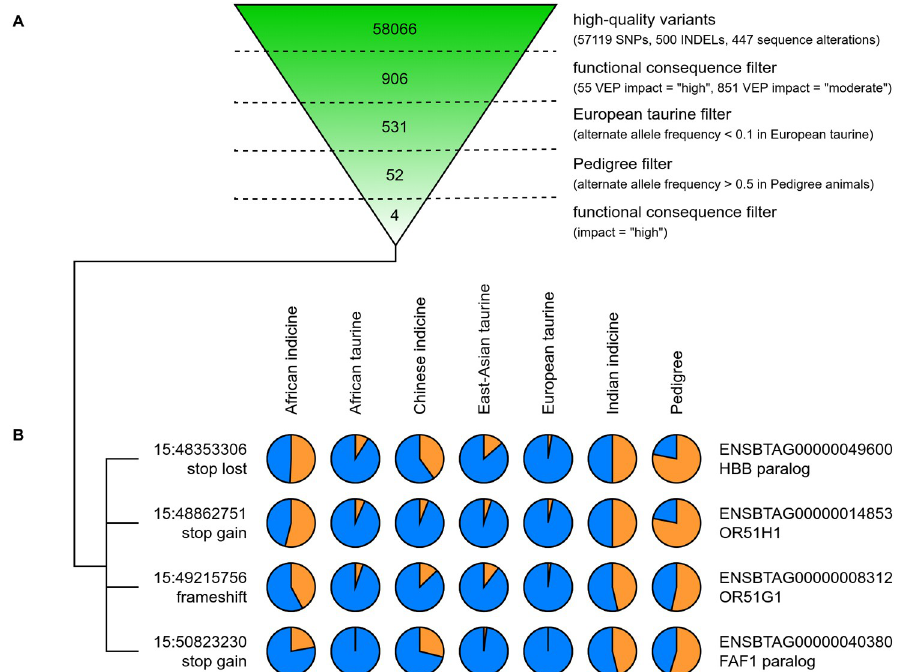
Fig 3. Prioritisation of variants. (A) Successive filters were applied to the high-quality variants in the region identified as significantly associated with tolerance to T . parva infection (15:45–51 Mb). This reduced the number of variants from 93960 to four predicted to have a high functional consequence by the Ensembl Variant Effect Predictor (VEP), a low alternate allele frequency (aAF < 0.1) in European taurine animals, and a high alternative allele frequency in Pedigree animals (aAF > 0.5). (B) The allele frequencies (reference allele in blue, alternative allele in orange) of these four variants were subsequently calculated in different populations (145 European taurine animals, 44